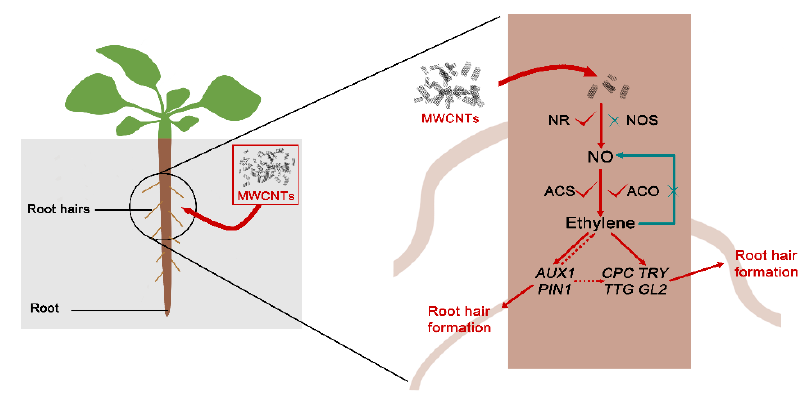
Figure 9. A model depicting the involvement of NO and ethylene in MWCNTs-induced root hair development.